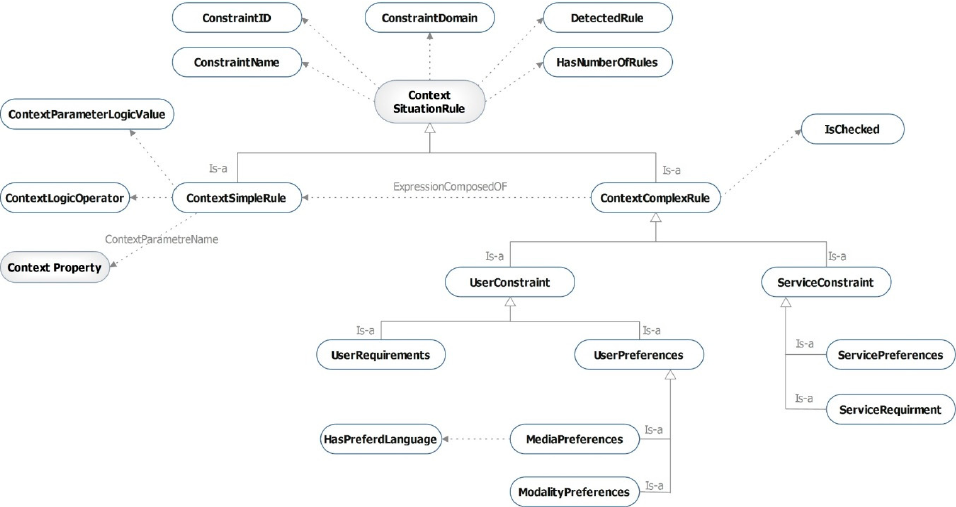
Figure 10. Context constraint sub ‐ ontology.